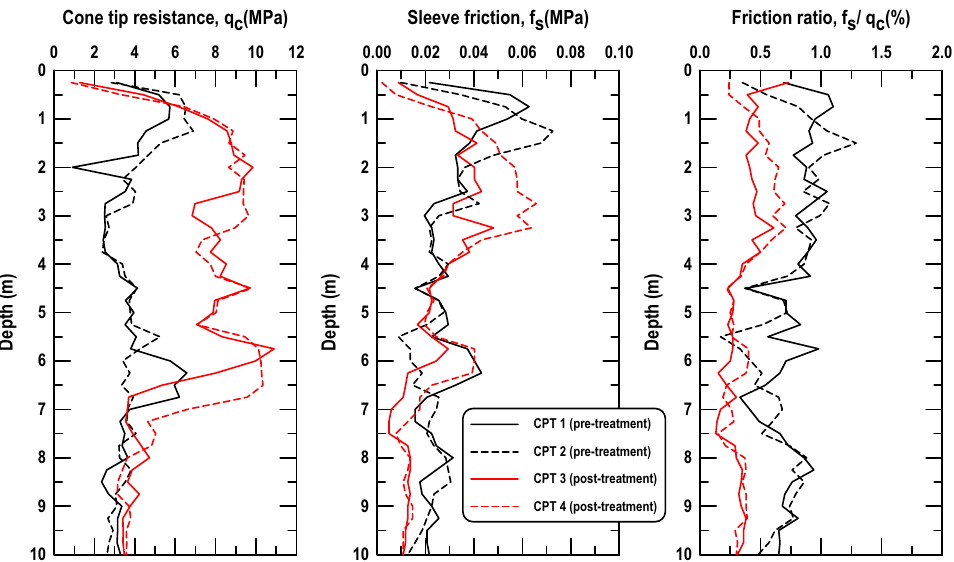
Figure 5. CPT investigation profiles before and after RIC treatment at the trial test site.